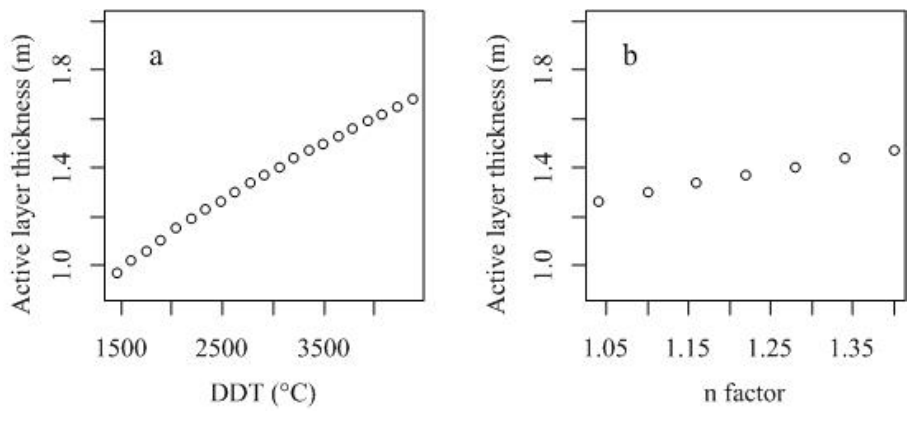
Figure 3. Active layer thickness in response to the sensitivity of parameters of ( a ) the degree-day of thaw (DDT) and ( b ) summer n-factor in the Stefan equation.